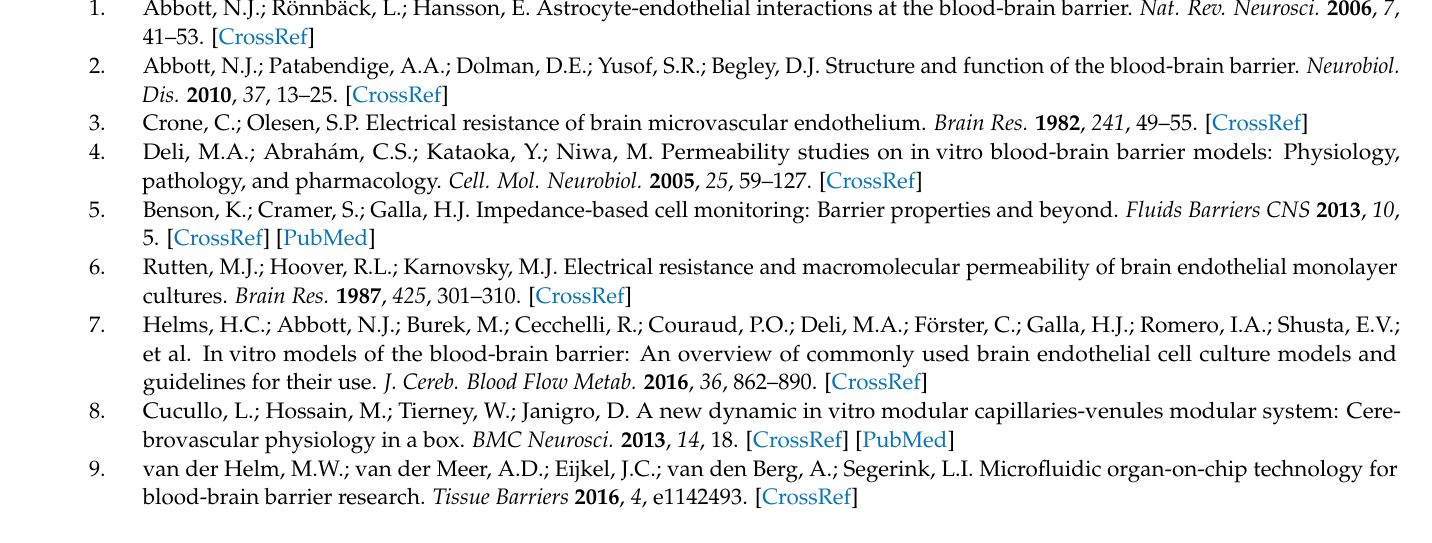
setup, Figure S4: Schematic representation of the cellZscope system, Figure S5: Screenshot of the graphical user interface (GUI) of the Comsol software, Figure S6: Comsol modeling of electrical resistance measurement across culture